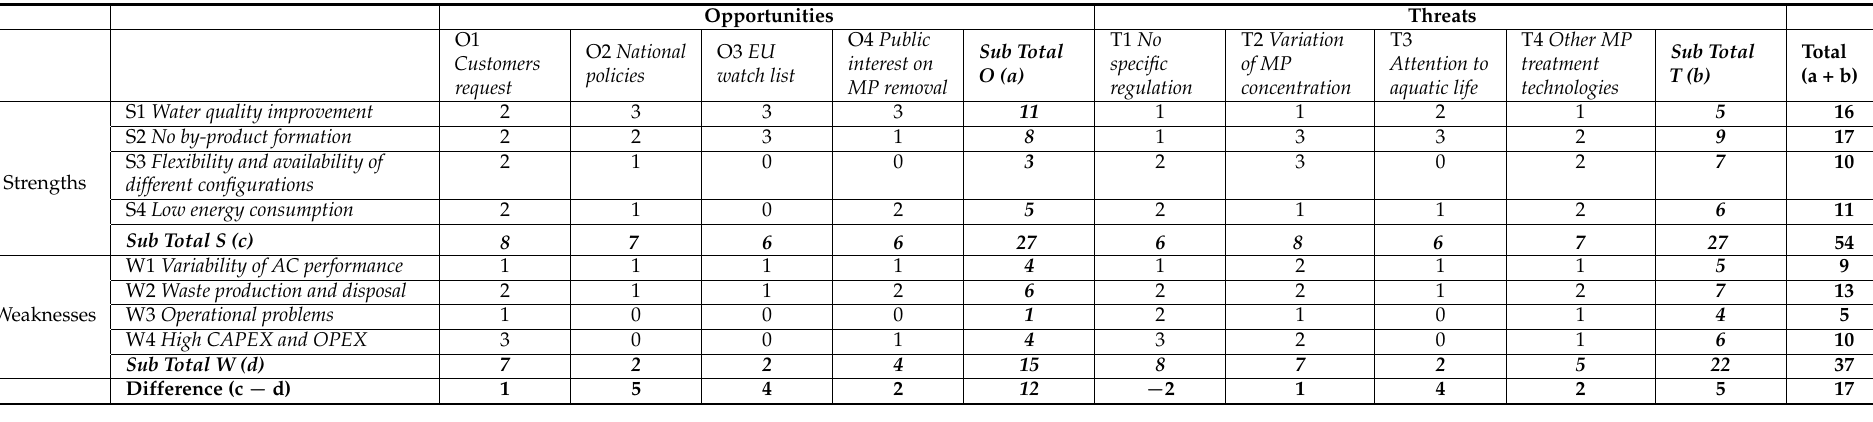
Table 5. SOR matrix for AC technology.